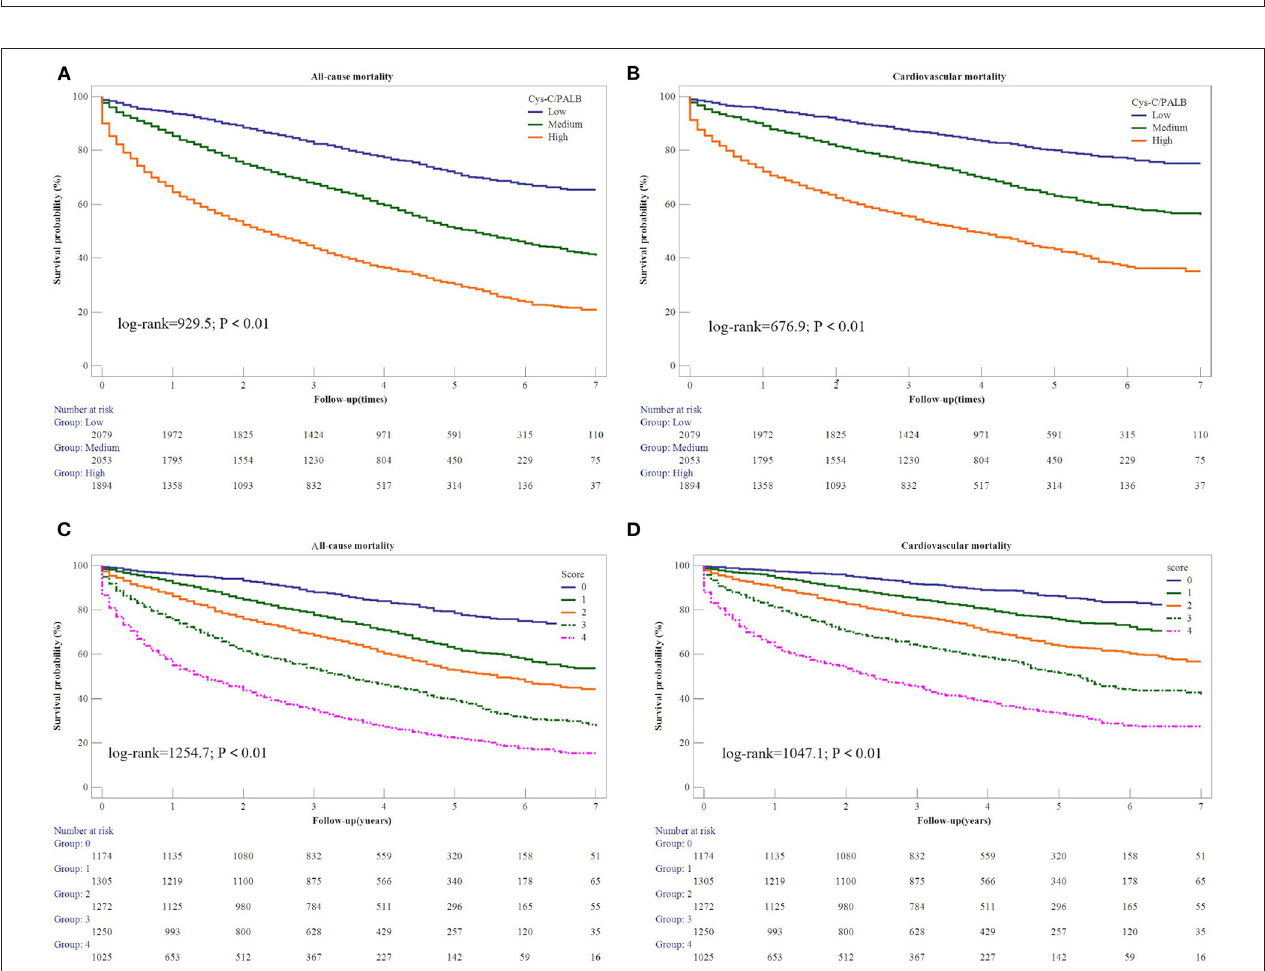
FIGURE 2 | Kaplan-Meier estimates of all-cause mortality (A) and cardiovascular mortality (B) based on Cys-C/PAB ratio. Kaplan-Meier estimates of all-cause mortality (C) and cardiovascular mortality (D) based on scores of Cys-C/PAB ratio and NT-proBNP.